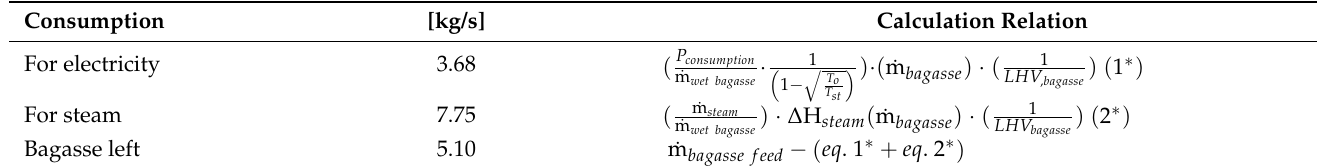
Table A4. Wet bagasse consumption to electricity generation and steam production (16.5 kg/s), as well as bagasse left for biofuel production.